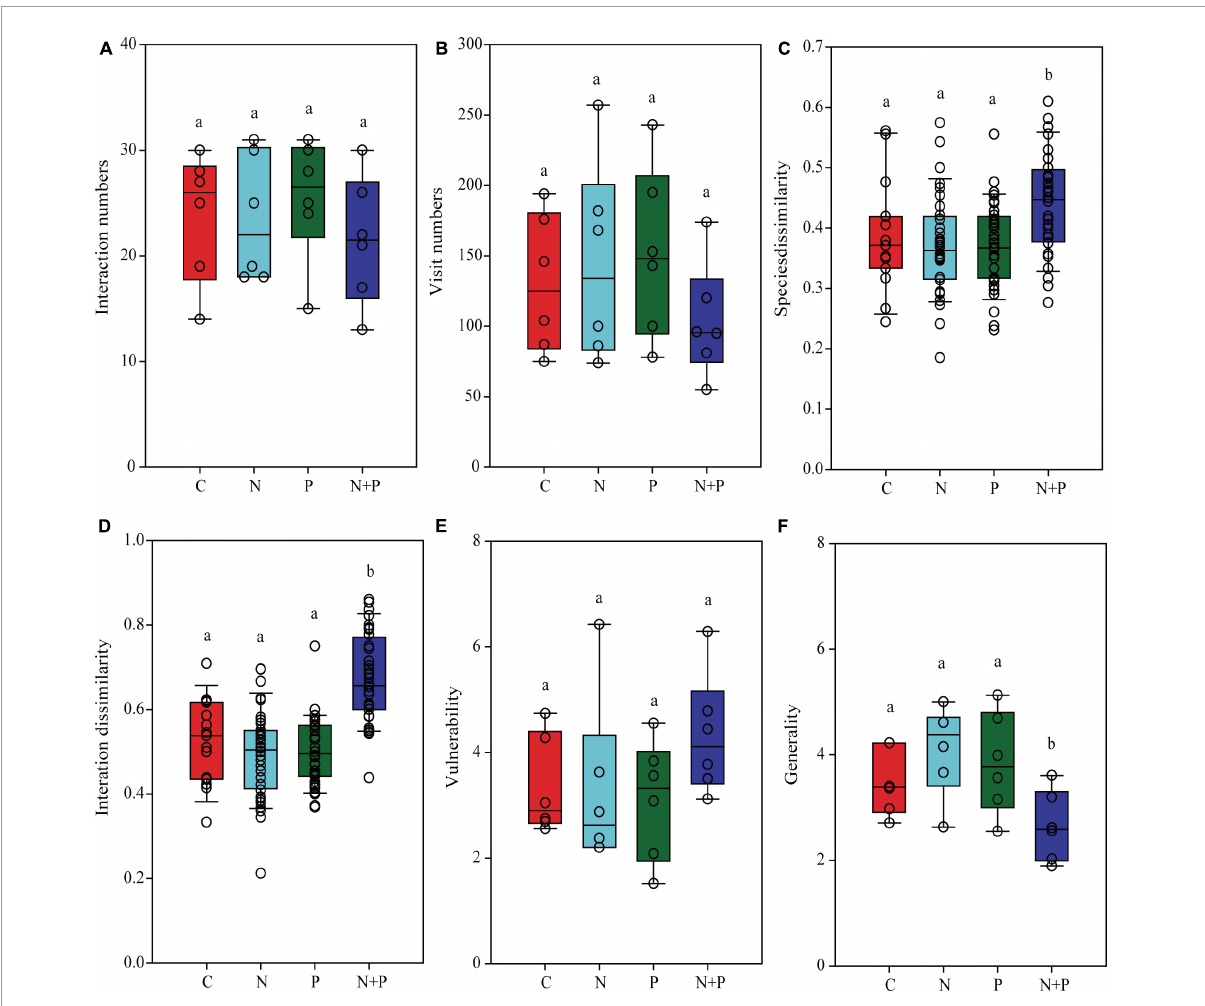
FIGURE4 The effects of nutrient enrichment on the links between plants and pollinators. (A) plant–pollinator interaction numbers, (B) pollinator visit numbers, (C) plant–pollinator species dissimilarity, (D) plant–pollinator interaction dissimilarity, (E) vulnerability, and (F) generality. Each panel shows a one-way analysis of variance used to examine the differences between different nutrient treatments. Different lowercase letters on the bars indicate significant differences in nutrient supply at the 0.05